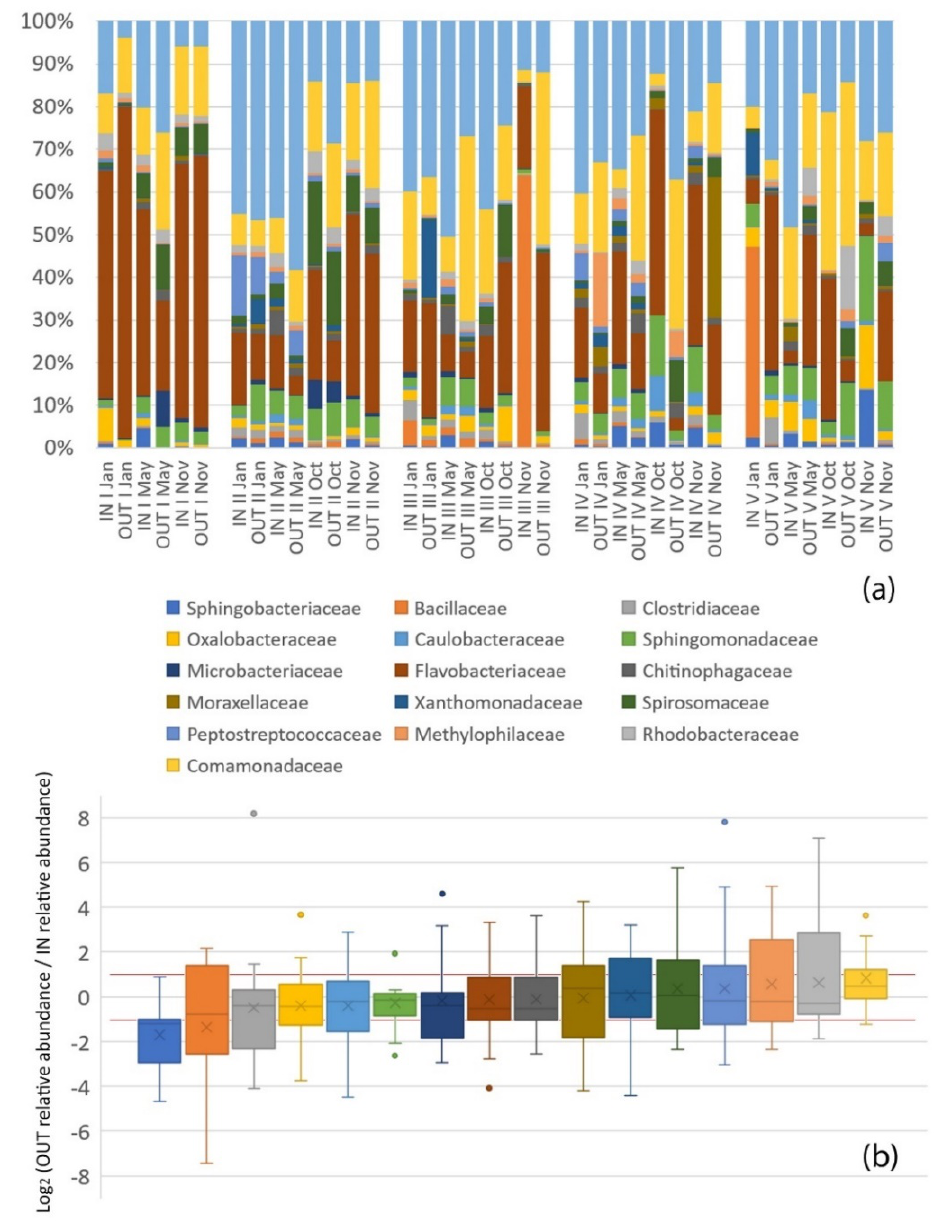
Figure 5. ( a ) Proportion of the different microbial families present in samples collected upstream (IN) and downstream (OUT) from the five (I–V) investigated hydrokarst systems. ( b ) Box plots showing the distribution of the ratios between downstream and upstream locations on a Log2 scale. The ratios were calculated per site per time point. The red lines mark +1 and − 1, representing a 2-fold increase or decrease in downstream communities,